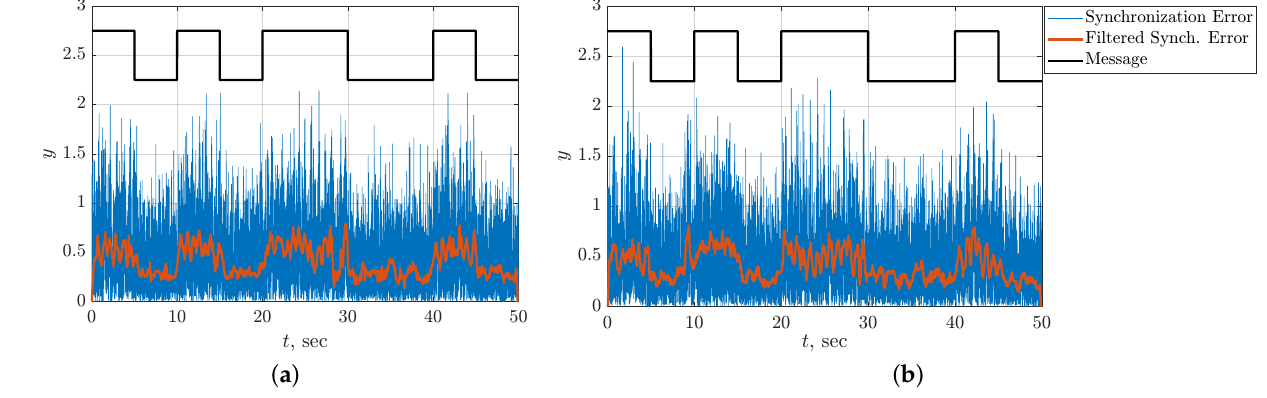
Figure 6. Synchronization error on the receiver side for ( a ) PM and ( b ) SCM